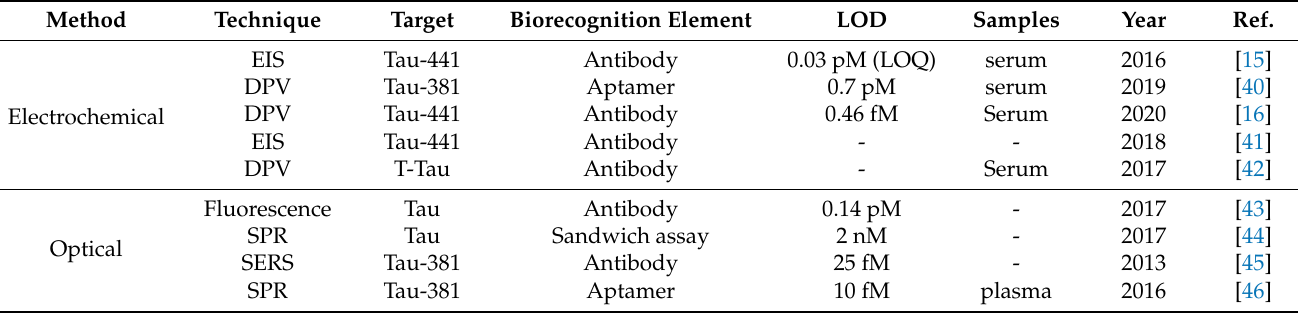
Table 1. Biosensors to detect Tau protein.